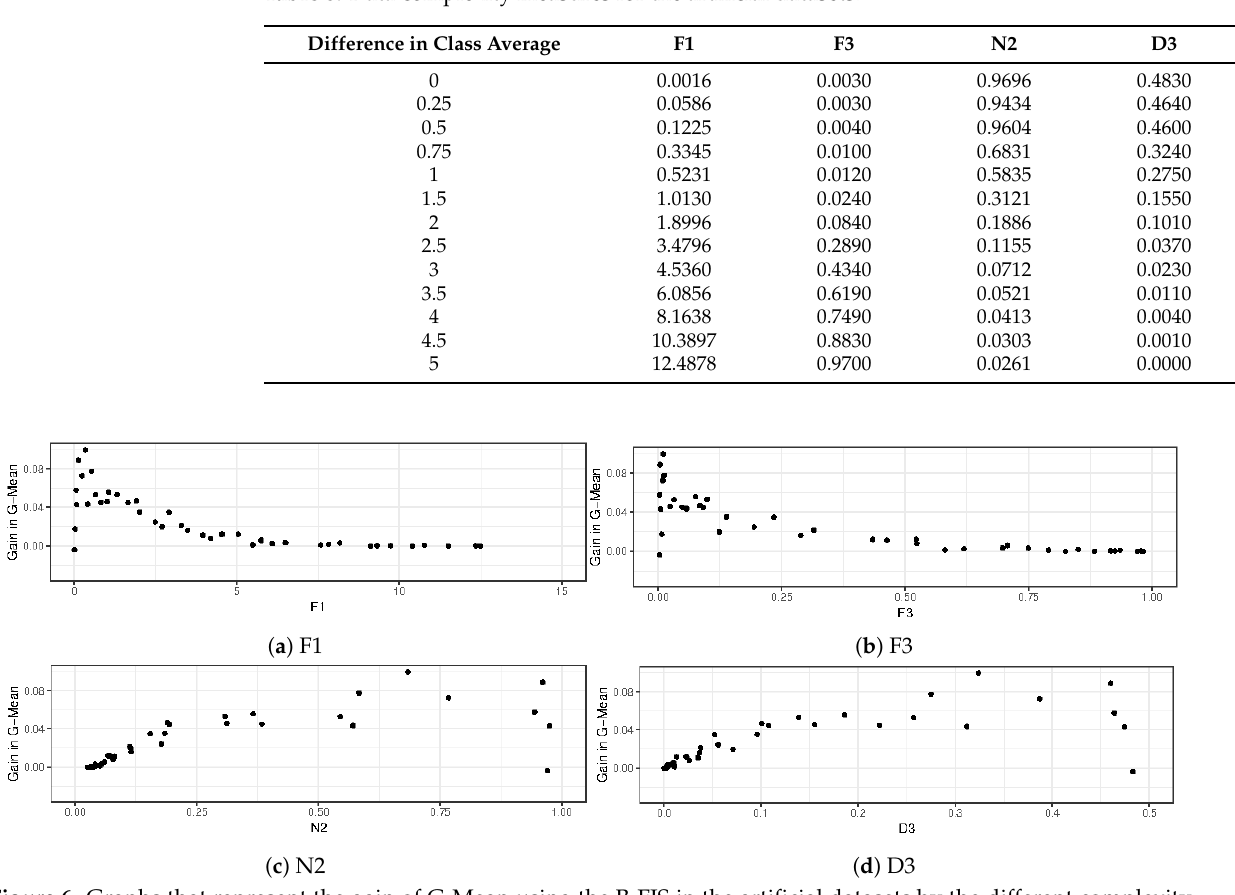
Figure 6. Graphs that represent the gain of G-Mean using the B-FIS in the artificial datasets by the different complexity measures. In the case of F1 and F3, low values represent high class overlapping, while, for N2 and D3, low values represent low class overlapping.